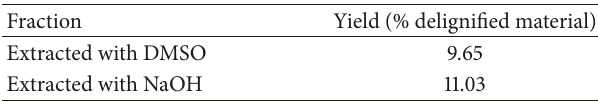
Table 1: Yields of hemicelluloses during extraction with DMSO and NaOH based on starting